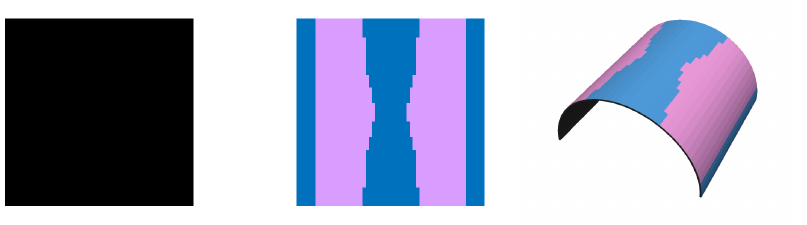
Figure 2. Structure layout ρ s ( left ), electrode profile ρ p ( centre ) and 3D design ( right ) for the first example.